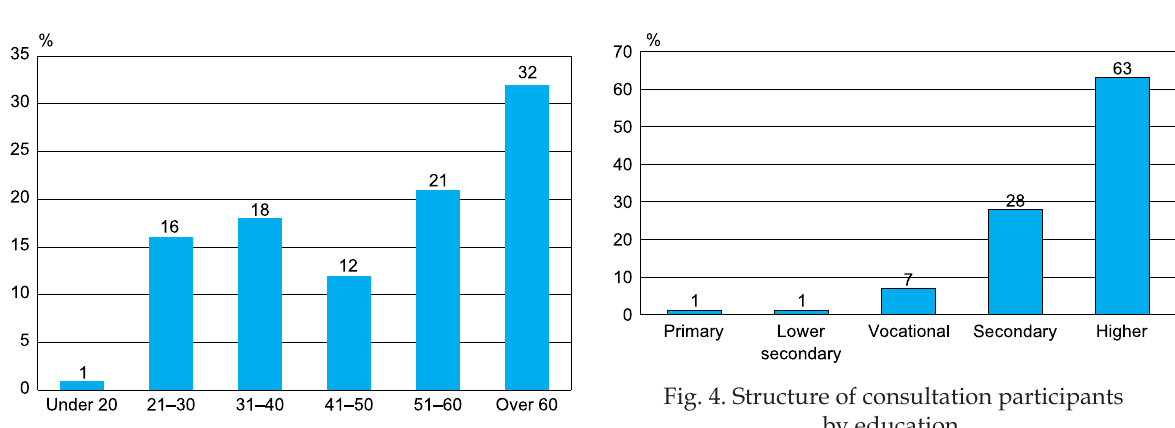
Fig. 3. Structure of consultation participants by age. Source: own compilation.